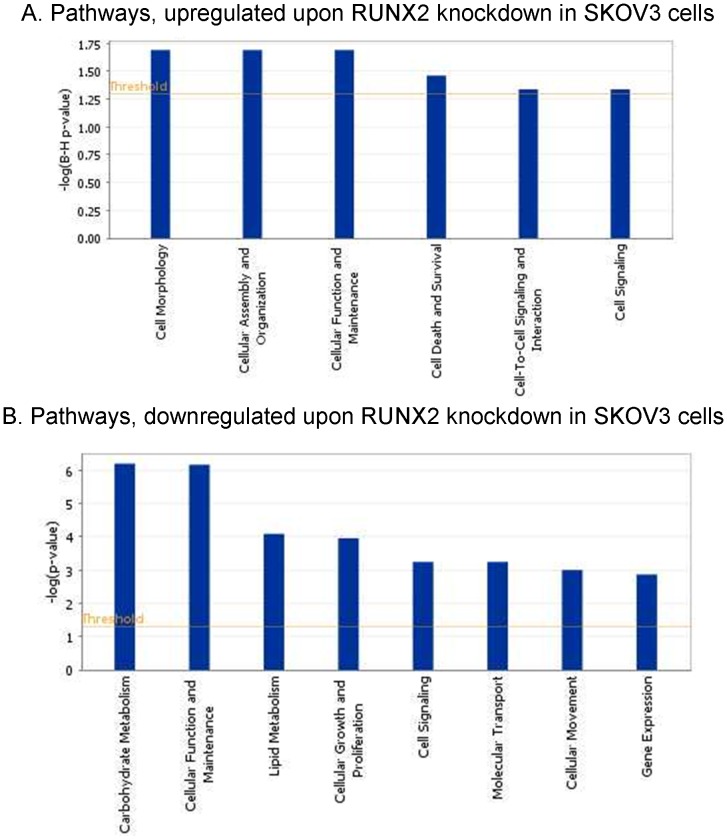
Functional analysis for a dataset of differentially expressed genes (≥2-fold) following RUNX2 suppression in SKOV3 cells.A. Functional analysis of upregulated genes; B. Functional analysis of downregulated genes. Top functions that meet a p-value cutoff of 0.05 are displayed.